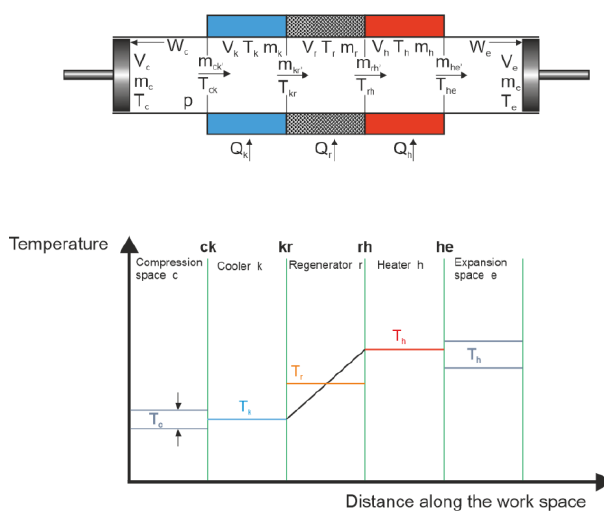
Fig. 11. Temperature profile in workspaces for adiabatic model [22] The values of temperature on the domain is conditioned by flow direction. Mass flow rate flowing through the do- main ck equals m ’. Positive mass flow rate means gas ck flow to expansion space, whereas negative is correlated with flow in opposite direction. The value of temperature